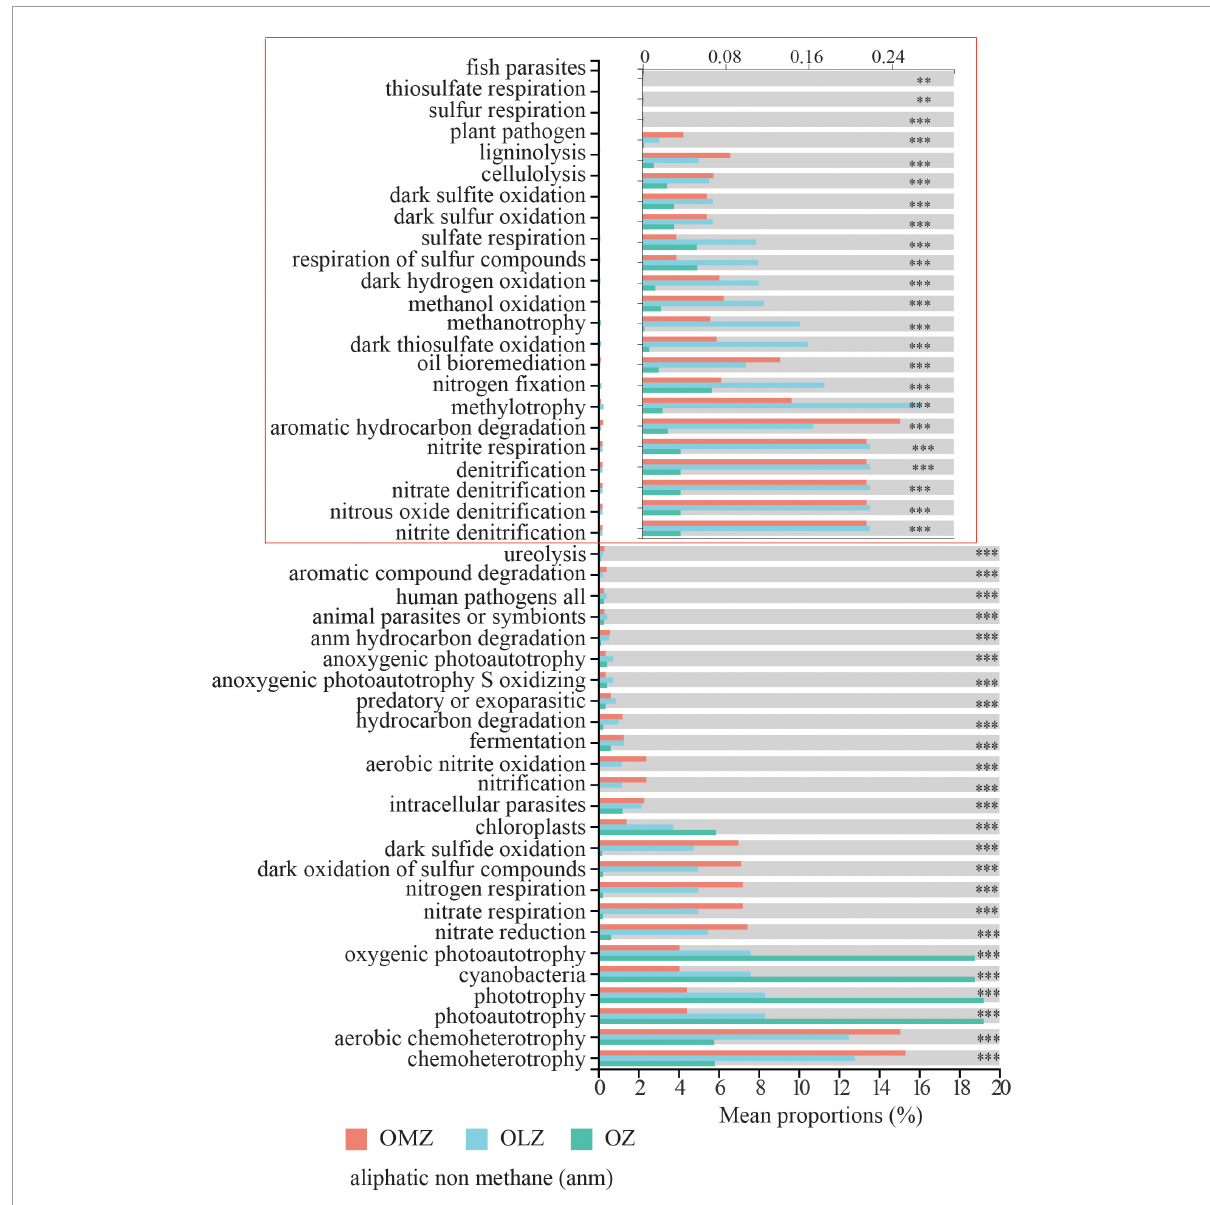
FIGURE8 Functional Annotation of Prokaryotic Taxa (FAPROTAX) function predication plot showed mean proportions of predicated functions in OMZ, OLZ, and OZ. Games–Howell were used in the statistical test. ∗∗ p < 0.01; ∗∗∗ p < 0.001. Since the mean proportions of some functions (in red box) is very less, the x-axis was enlarged, and the number marked in the x-axis in red box was still the real mean proportions of each